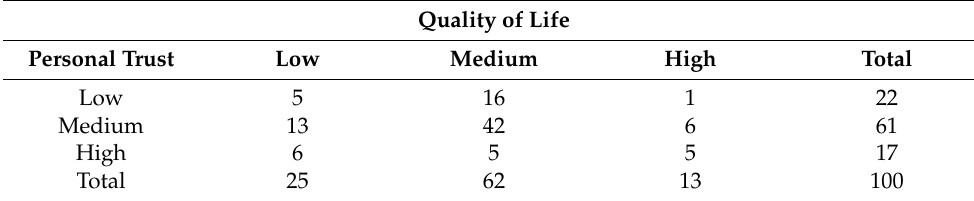
Figure 3. Distribution of number of districts according to average values of quality of life and personal trust (in %). Table 3. Distribution of number of observed characters in